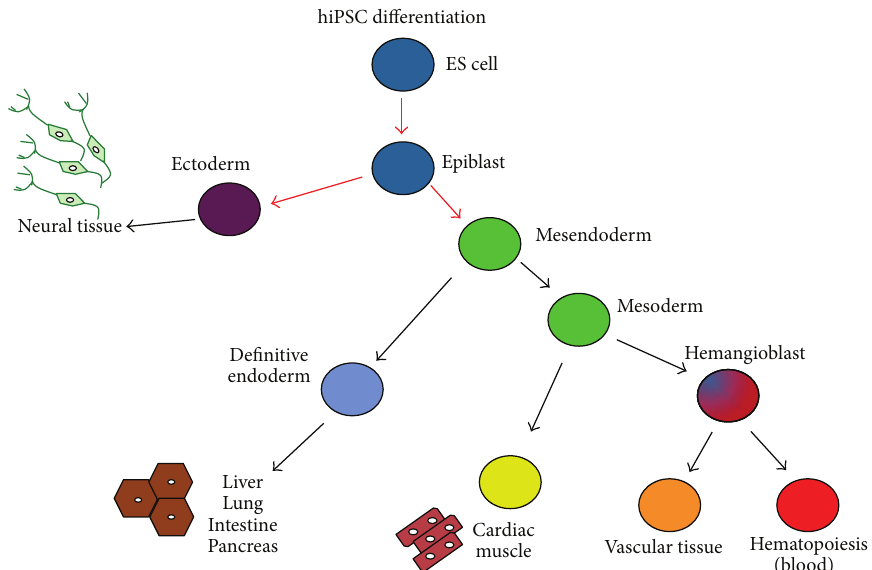
Figure 2: Human iPSC can be differentiated into all cell